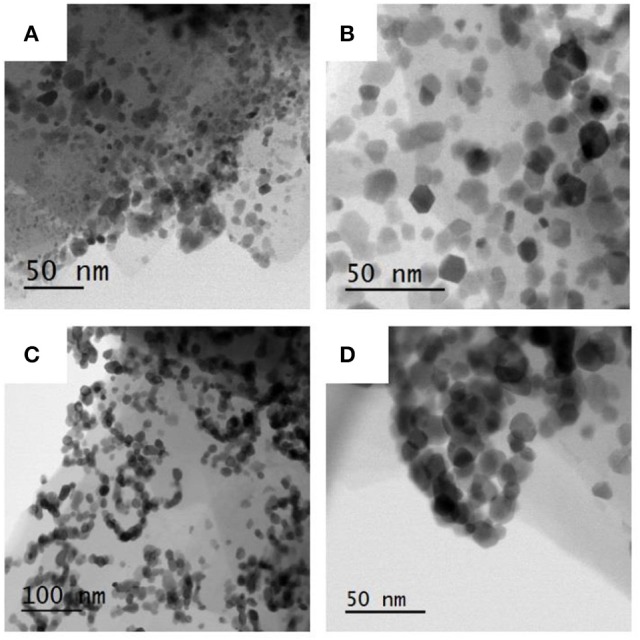
STEM-BF micrographs of NiO particles on zeolite crystallites: (A) Ni/HZSM-5-1, (B) Ni/HZSM-5-3, (C, D) Ni/HZSM-5-5 (note chain-like network of particles).